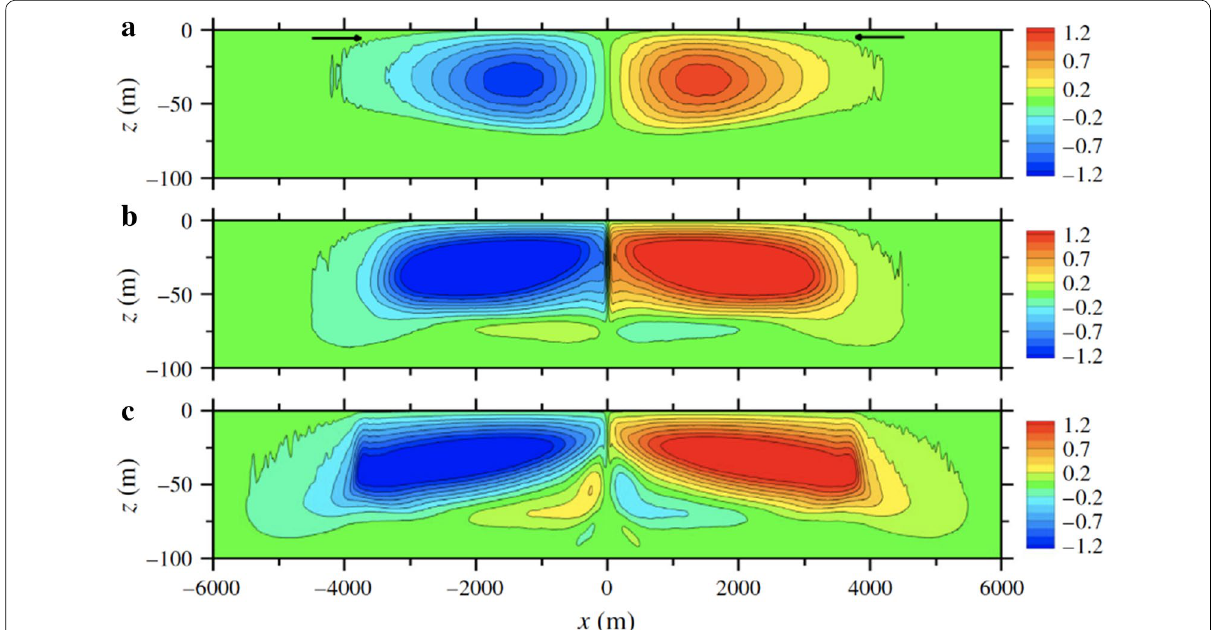
Fig. 10 Filament secondary circulation. The associated cross-front streamfunction (cid:31) at three different times in the filament life-cycle: (top-to-bottom) initial condition for frontogenesis ( t = 0 ), during the peak time of frontal arrest ( t = 6 h), and during an extensive period of frontal decay ( t = 2 days). Notice the strong, narrow surface convergence that is the cause of the frontal sharpness. This is for the same simulation as in Fig. 9 (Sullivan and McWilliams